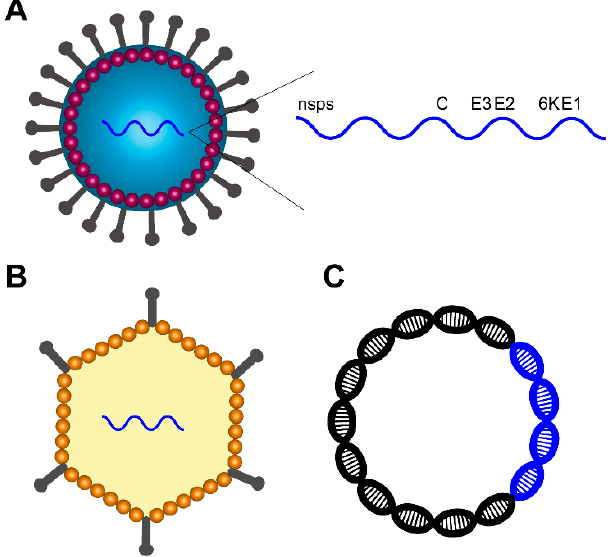
Figure 1. Vaccine strategies against encephalitic Alphavirus infections. ( A ) Schematic overview of encephalitic the Alphavirus structure, including the genome organization of nonstructural proteins (nsps), capsid ( C ), assembly protein (E3), spike glycoproteins (E2 and E1), and viroporin protein (6K). ( B ) Viral vector delivery of encephalitic Alphavirus genes (blue). ( C ) Plasmid DNA containing backbone (black) and encephalitic Alphavirus DNA (blue).